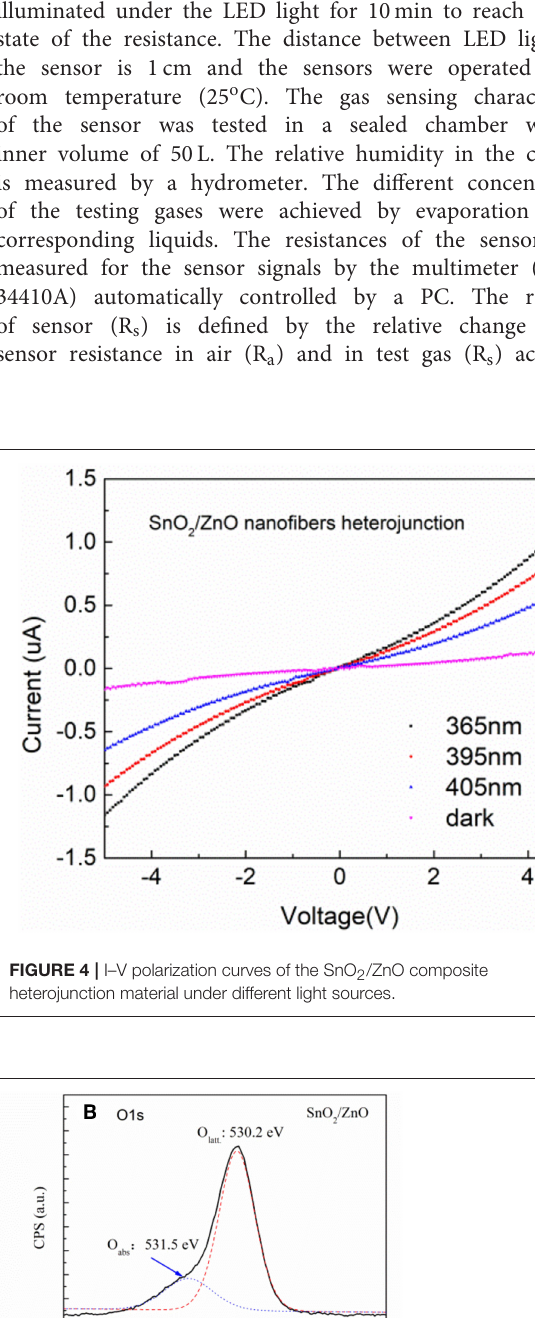
Frontiers in Materials |